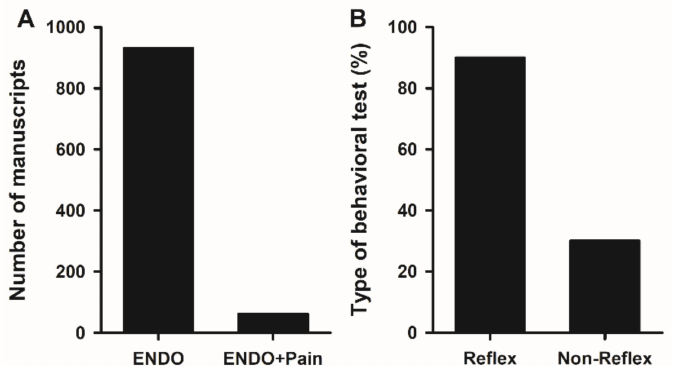
Figure 3. Preclinical model of endometriosis and pain. ( A ) Number of research articles that evaluated pain compared to all articles studying endometriosis in rodents. ( B ) Percentage of research articles that evaluated endometriosis-associated pain using reflex vs. non-reflex tests.